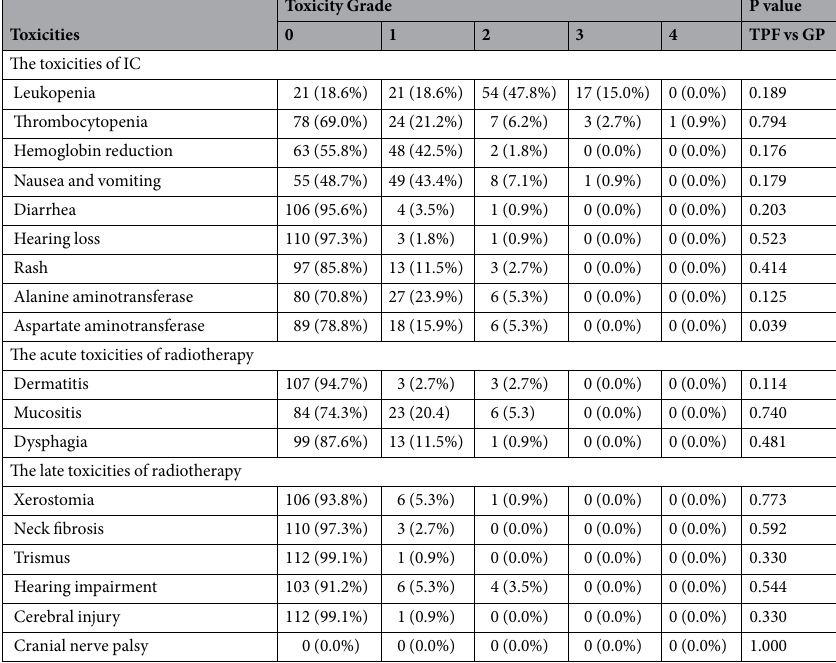
Table 5. Toxicities of induction chemotherapy and